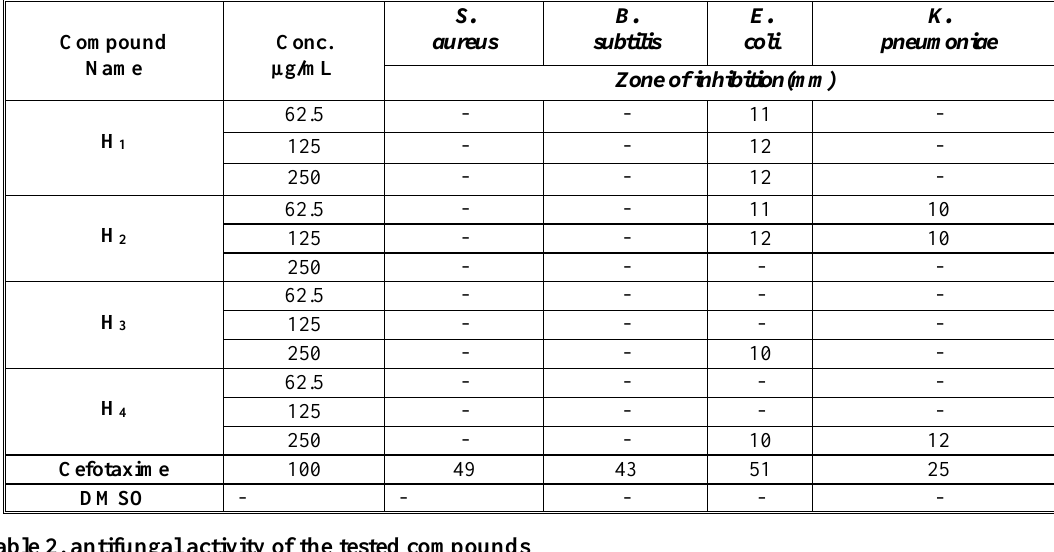
Table 1. antibacterial activity of the tested compounds